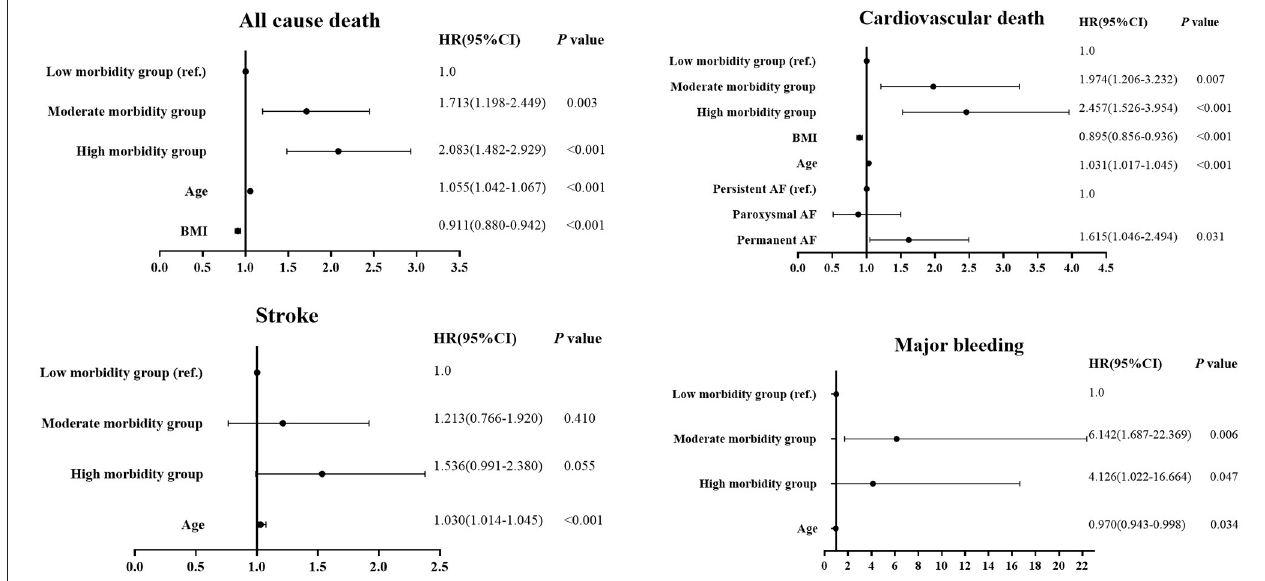
FIGURE 3 | Multivariate Cox proportional models of predictors for all-cause death, cardiovascular death, stroke, and major bleeding by morbidity